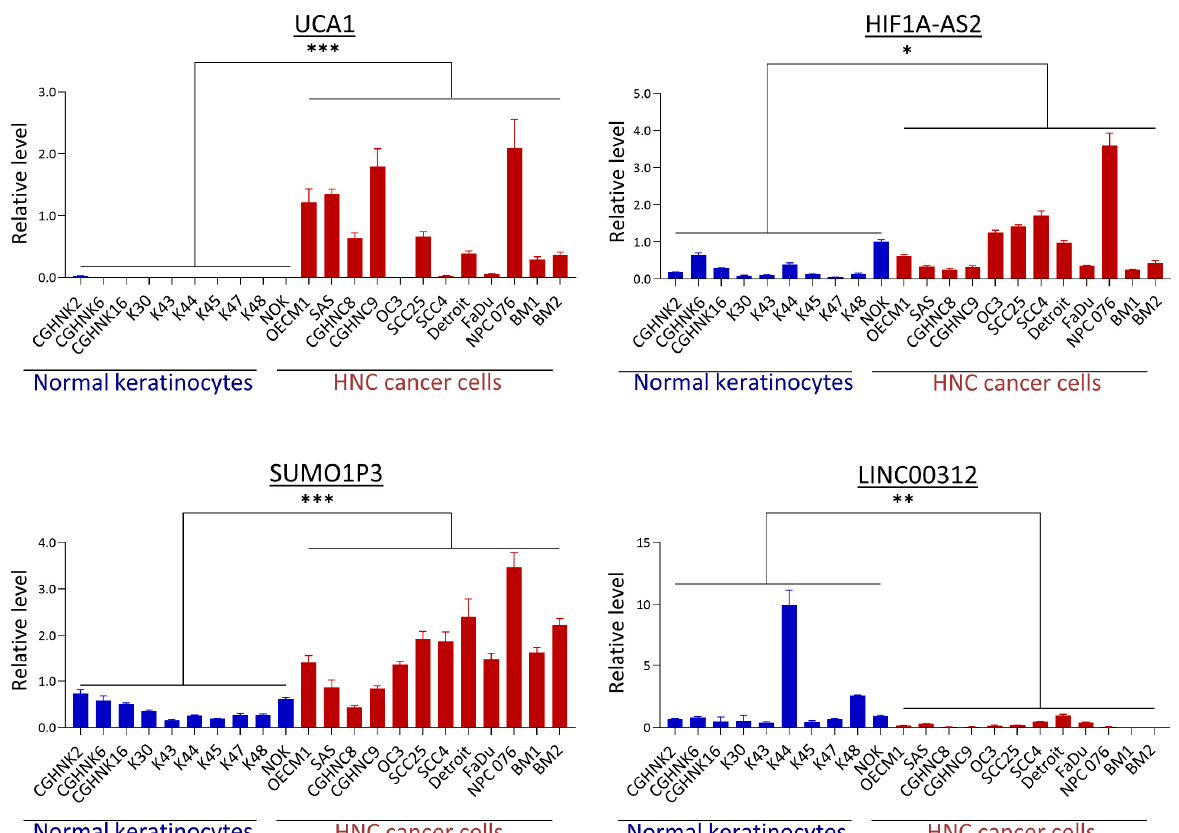
Figure 3. The integration of lncRNAs that were dysregulated in areca nut-treated HNC cells and altered expression in tumors from TCGA-HNSC dataset. ( a ) Overview of eight upregulated lncRNAs and two downregulated lncRNAs, with the levels of fold-change in response to area nut ( X -axis) and the differential significance ( p values) between tumors and normal tissues ( Y -axis). ( b ) Expressions of six lncRNAs (LUCAT1, MIR31HG, UCA1, HIF1A-AS2, SUMO1P3, and LIN00312) dysregulated in five HNC cell lines treated with arecoline (100 μ M for 24 h), as examined by RT-qPCR method. ( c , d ) Expression of three lncRNAs (LUCAT1, MIR31HG, and UCA1) in three HNC cells treated with arecoline by serial doses (0~200 μ M) ( c ) for various time points (0~72 h) ( d ). ( e ) Expressions of six lncRNAs differential presented between 12 HNC cell lines and ten cell lines of normal oral keratinocytes. (*: p < 0.05, **: p < 0.01, ***: p < 0.001).